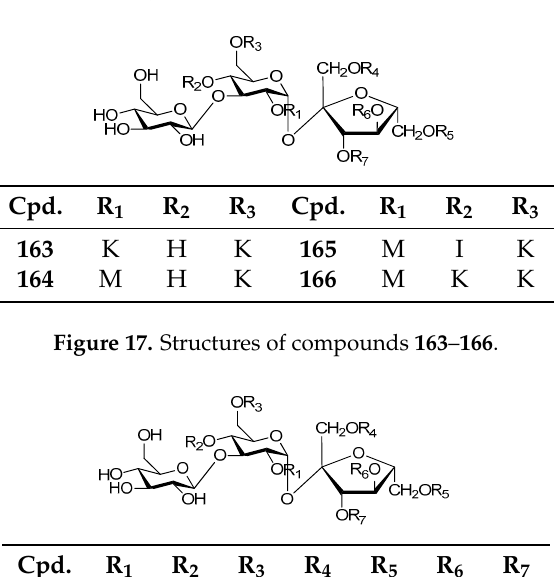
Figure 18. Structures of compounds 167 – 168 .